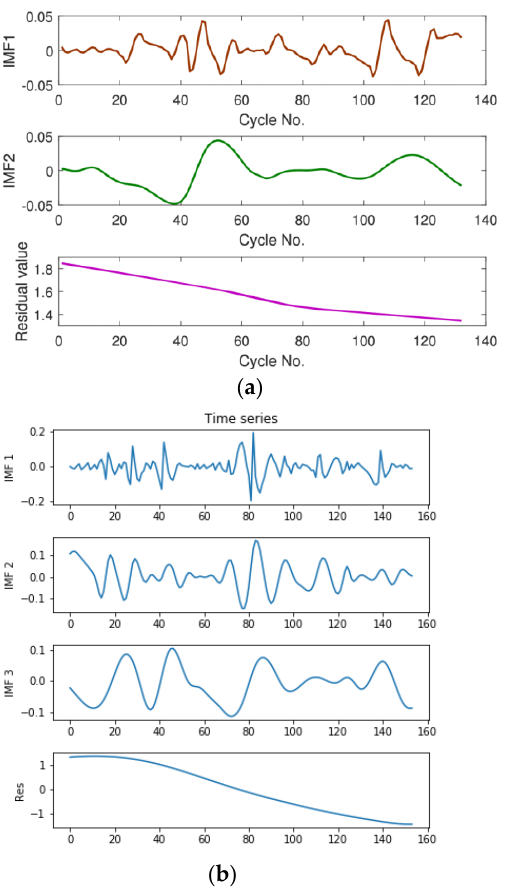
Figure 3. ( a ) EMD Decomposition Example 1; ( b ) EMD Decomposition Example 2